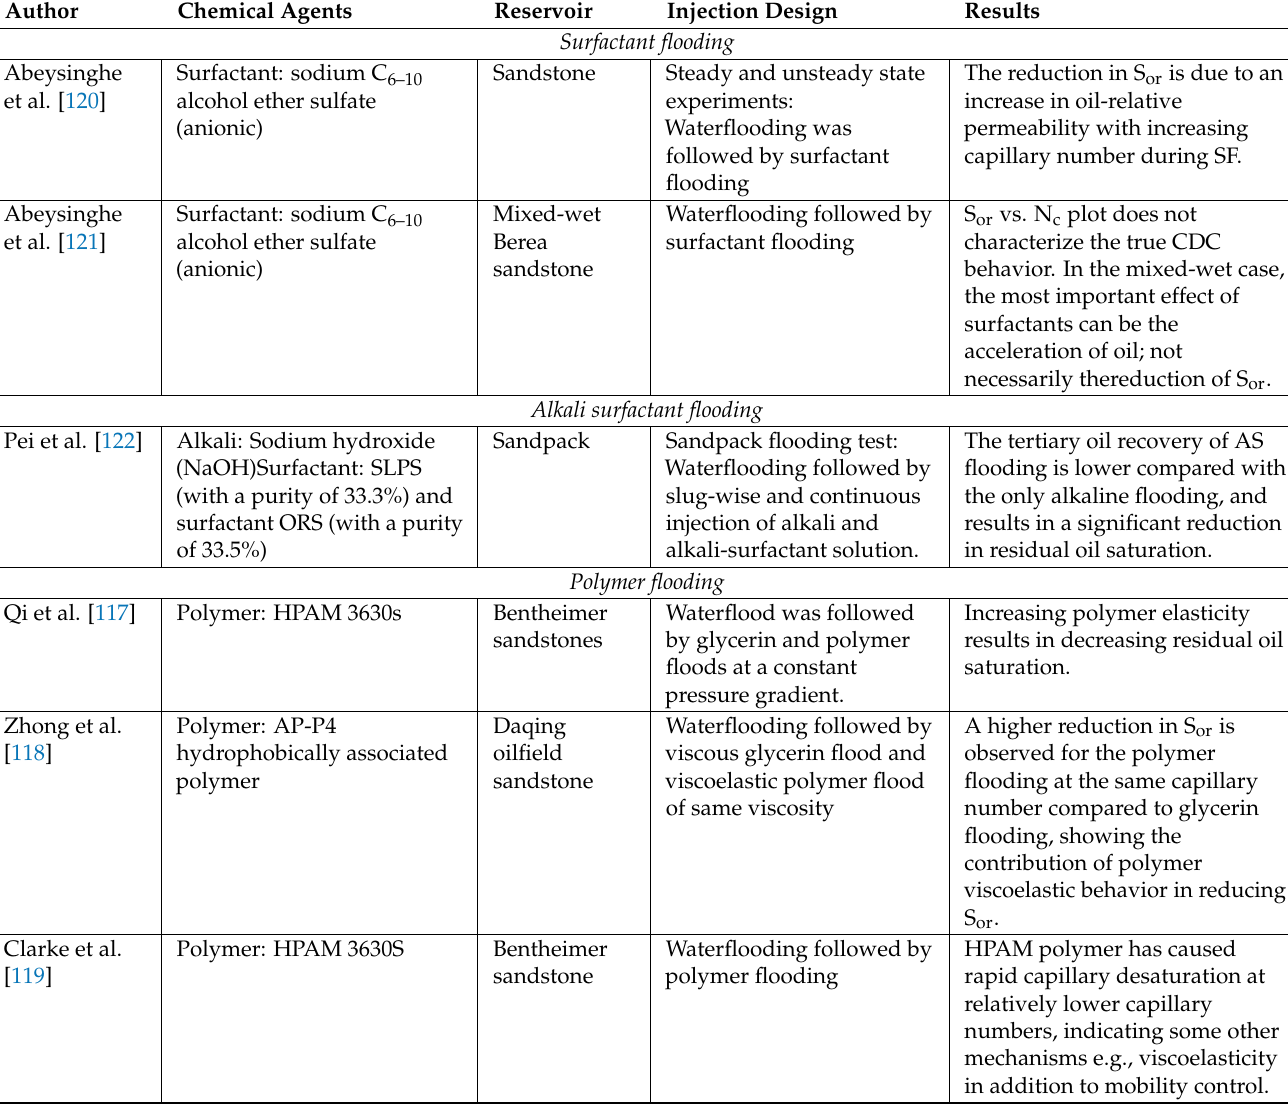
Table 2. Summary of conventional CDC studies used for